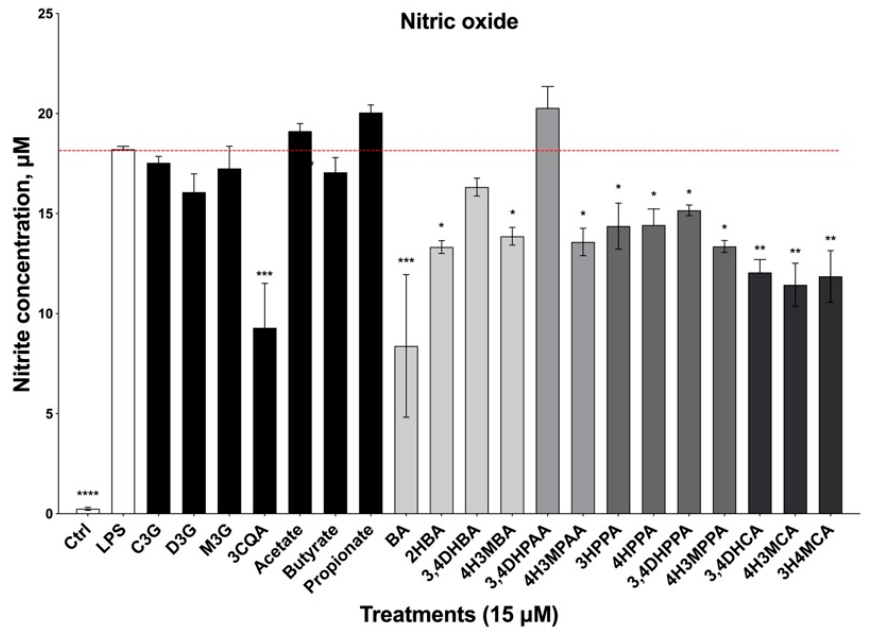
Figure 4. Effects of wild blueberry anthocyanins, short-chain fatty acids, and phenolic acid metabo- lites on nitric oxide production in activated macrophages. Cells were pre-treated with target metabo- lites and inflammatory response was induced with 1 µ g/mL LPS for 6 h. Changes in nitrite concen- tration as an indirect measure of nitric oxide production were reported as mean ± SEM relative to the LPS controls (* p < 0.05, ** p < 0.01, *** p < 0.001, **** p < 0.0001). The remaining methylated hydroxycinnamic acid metabolites used in this study were also effective at reducing nitric oxide production to a similar degree of potency in the range of 22–31%. Finally, there was a trend to decrease nitric oxide release when macrophages were exposed to hydroxybenzoic acid metabolites, with benzoic acid being the most potent (a reduction of 54.6%, p < 0.05). Short-chain fatty acid, phenylacetic, and phenylpropanoic acid metabolites were largely ineffective in this assay. All groups of wild blueberry metabolites showed varying levels of modulation of gene expression profiles associated with acute and chronic biomarkers of inflammation (Cox-2, iNOS, IL-1 β , and IL-6). Cox-2 expression was most strongly affected by 3-caffeoylquinic acid − 1.72x ( − 72%) and 2-hydroxybenzoic acid − 1.76x ( − 76%), followed by metabolites from the hydroxybenzoic and hydroxycinnamic acids in the range of 22–56% and 38–61%, respectively, while short-chain fatty acids, phenylacetic, as well as phenylpropionic acids used in this study, showed little to no effects. A wider array of metabolites affected the expression of iNOS, albeit the overall magnitude of the effect was smaller than that of Cox-2. Many of the metabolites of both fiber and phenolic origin affected the expression levels of the early inflammatory IL-1 β gene with no clear specificity towards any subclass used in this study. The strongest inhibition of IL-1 β expression was achieved by treatment with 3-caffeoylquinic acid and its major metabolite 3,4-dihydroxycinnamic acid ( − 1.73x and − 1.81x, respectively), as well as 2-hydroxybenzoic acid ( − 1.65x). The mRNA levels of IL-6 were least affected by bioactive wild blueberry metabolites, as significant IL-6 mRNA decreases were observed only when cells were exposed to parent anthocyanin molecules (22–59%) and their hydroxycinnamic acid metabolites were in the range of 24–55%, as observed for the 3,4-dihydroxycinnamic, 4-hydroxy-3-methoxycinnamic,